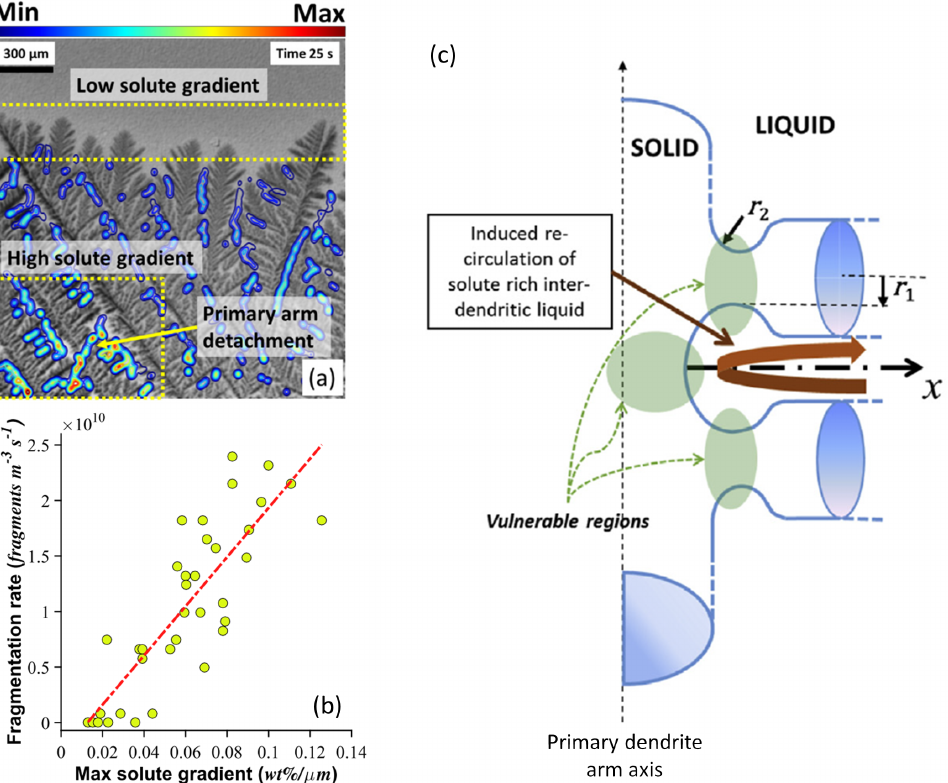
Figure 5. ( a ) A radiograph superimposed with a horizontal solute gradient contour map within the inter-dendritic channels of a solidifying Al-25wt.%Cu alloy. ( b ) The local dendrite fragmentation rate as a function of the maximum local inter-dendritic solute gradient in the liquid. The red dashed line represents a linear best-fit. ( c ) A schematic arrangement of two secondary dendrite arms attached to a primary arm showing regions that are more vulnerable to re-melting when the thermo-solute is perturbed due to their relatively high local curvature [23] (Reprinted with permission from [23]. Copyright 2016